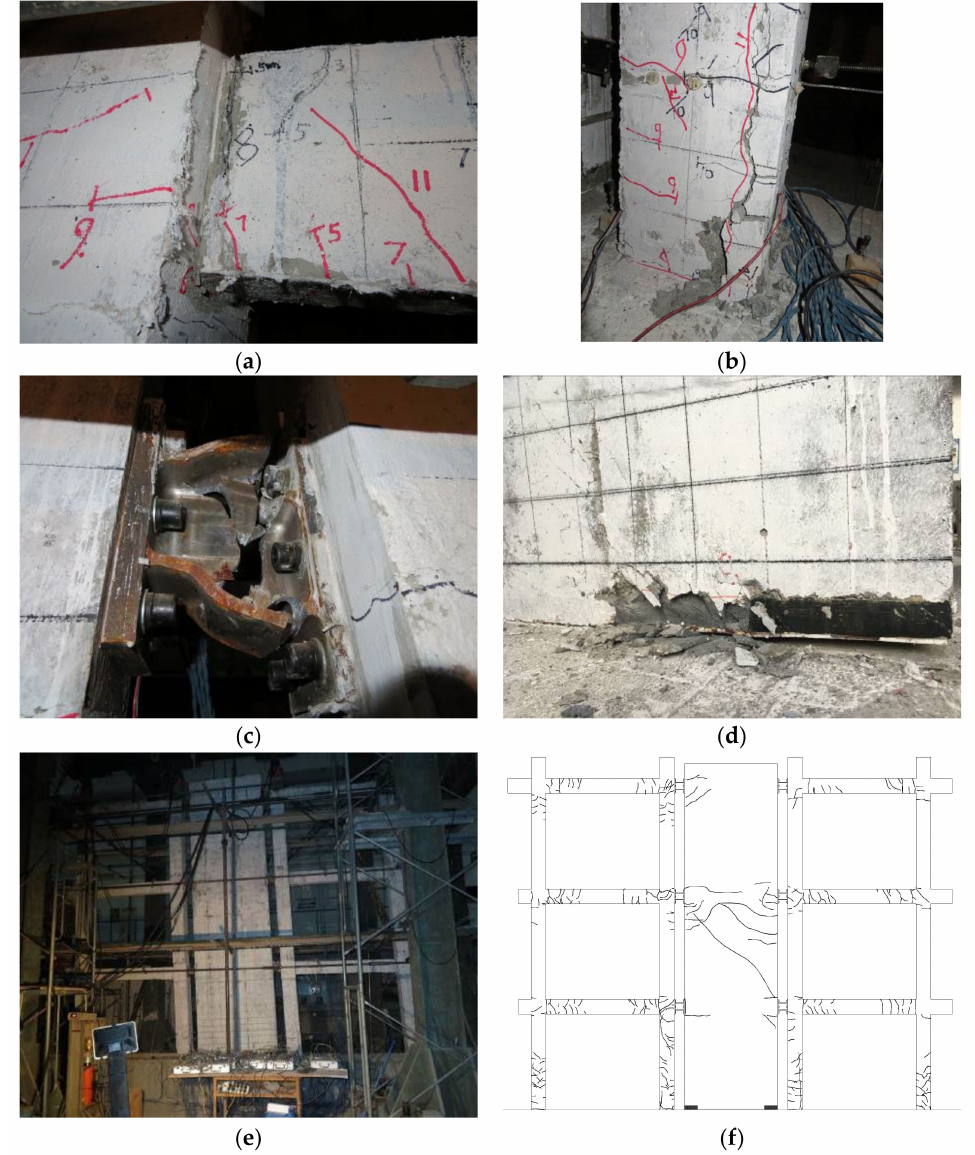
Figure 8. Damage of PFRW structure. ( a ) damage of first story beam at face of column A at +H/30; ( b ) damage at base of column C at +H/30; ( c ) damage to first story energy-dissipating connector at − H/30; ( d ) uplift and spalling at the base of the rocking wall at − H/30; ( e ) overall view of PFRW at − H/30; ( f ) final crack